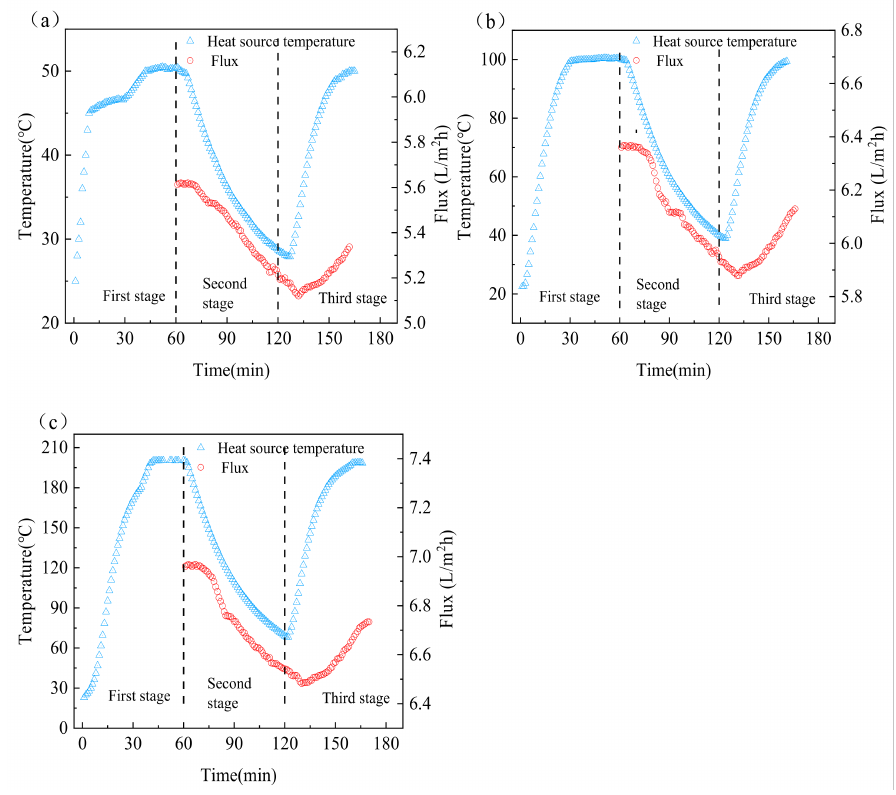
Figure 6. Changes in heat source temperature and flux with time in the intermittent heating process at heat source temperatures of ( a ) 50 ◦ C, ( b ) 100 ◦ C, and ( c ) 200 ◦